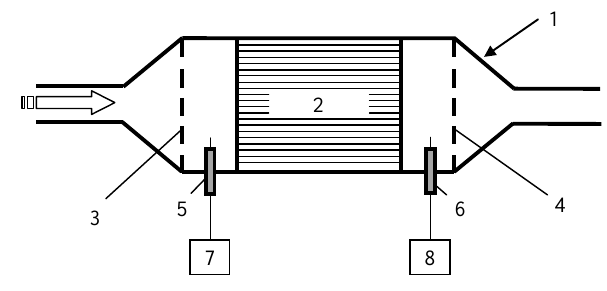
Figure 1. Basic structure of the proposed measurement